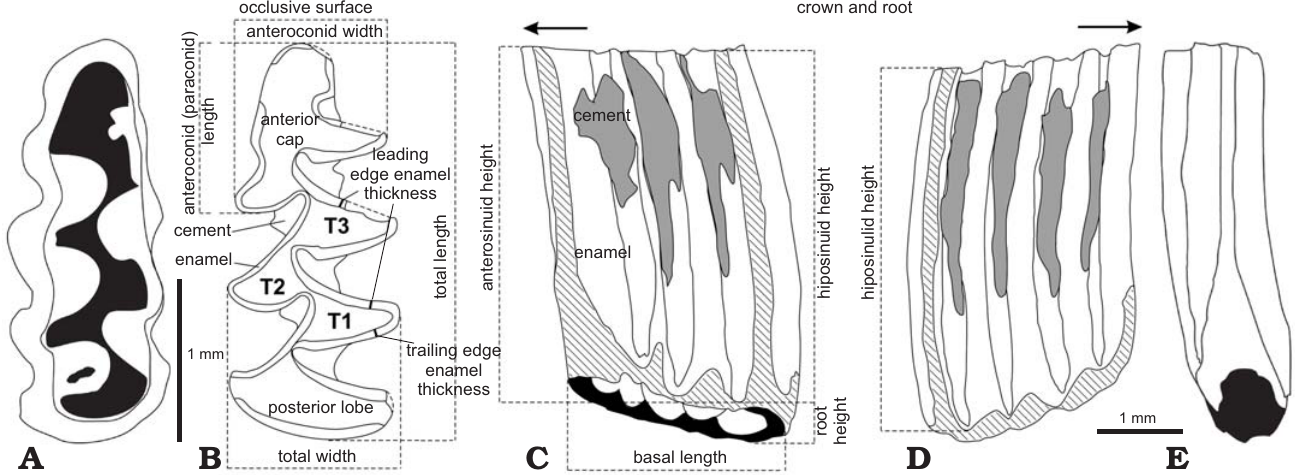
Fig. 3. Left m1 of a vole Mimomys chandolensis sp. nov. from Primorsky Krai, Russia, Late Pleistocene (MIS 3); ZIN 101600 in root ( A ), occlusal ( B ), buc- cal ( C ), lingual ( D ), and anterior ( E ) views. T1–3, the triangles of the occlusal suface; dentine tracks and fields of lateral sides are hatched; arrows mark the anterior direction. Terminology and measurements modified from van der Meulen (1973), Rabeder (1981), Tesakov (2004), Lozano-Fernández et al. (2013).